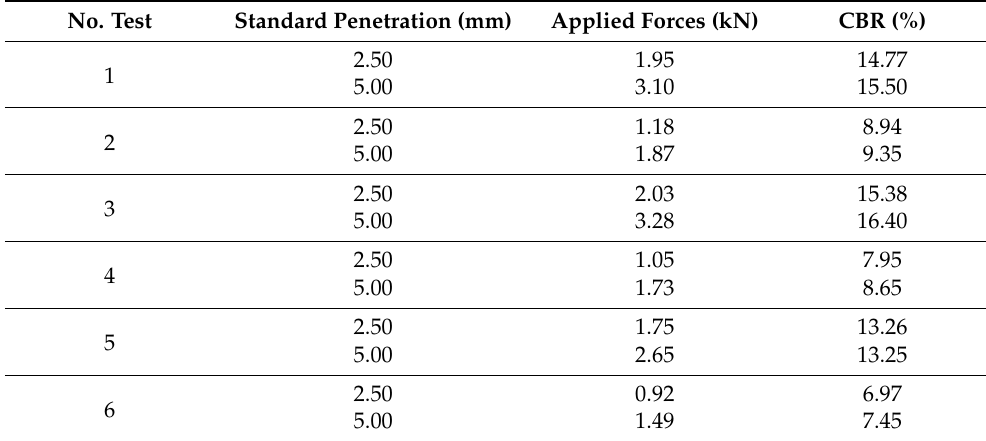
Table 3. Applied forces (kN) and estimated CBR (%) values per test and standard penetration. No. Test Standard Penetration